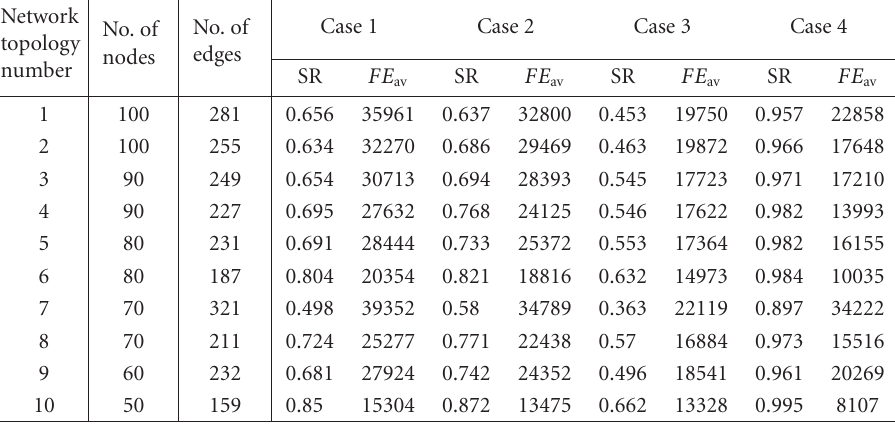
Table 4 . 1 . Performance comparison among di ff erent case studies involving PSO for the SPP.